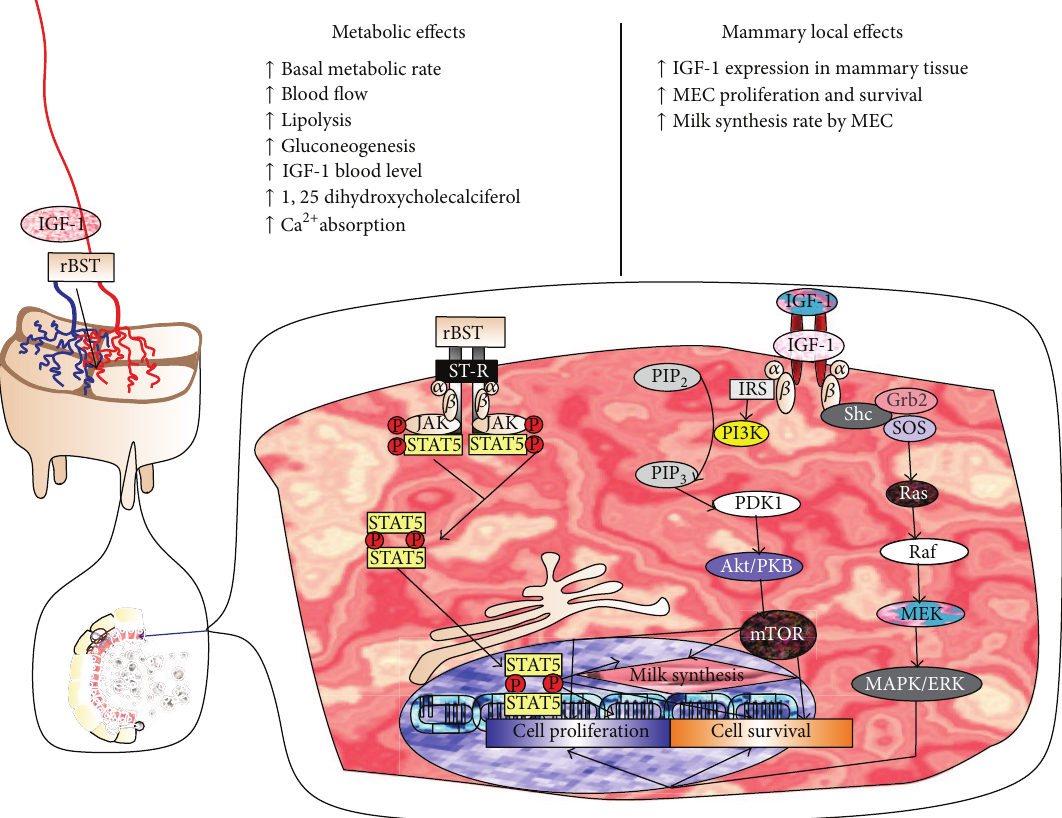
Figure 4: Proposed mechanism of action of recombinant bovine somatotropin (rBST). This hormone has direct effects on basal metabolic rate and breast parenchyma; the effects on the MEC(blue arrow) are mediated by rBST/ST-Rcomplex, which stimulates JAK2/STAT5 pathway and by IGF-1R/IGF-1 which promotes and upregulates IRS/PI3K/(AKT/PKB)/mTOR and Ras/Raf/(MAPK/ERK) pathways. This will induce cell proliferation and survival and increase milk protein synthesis in